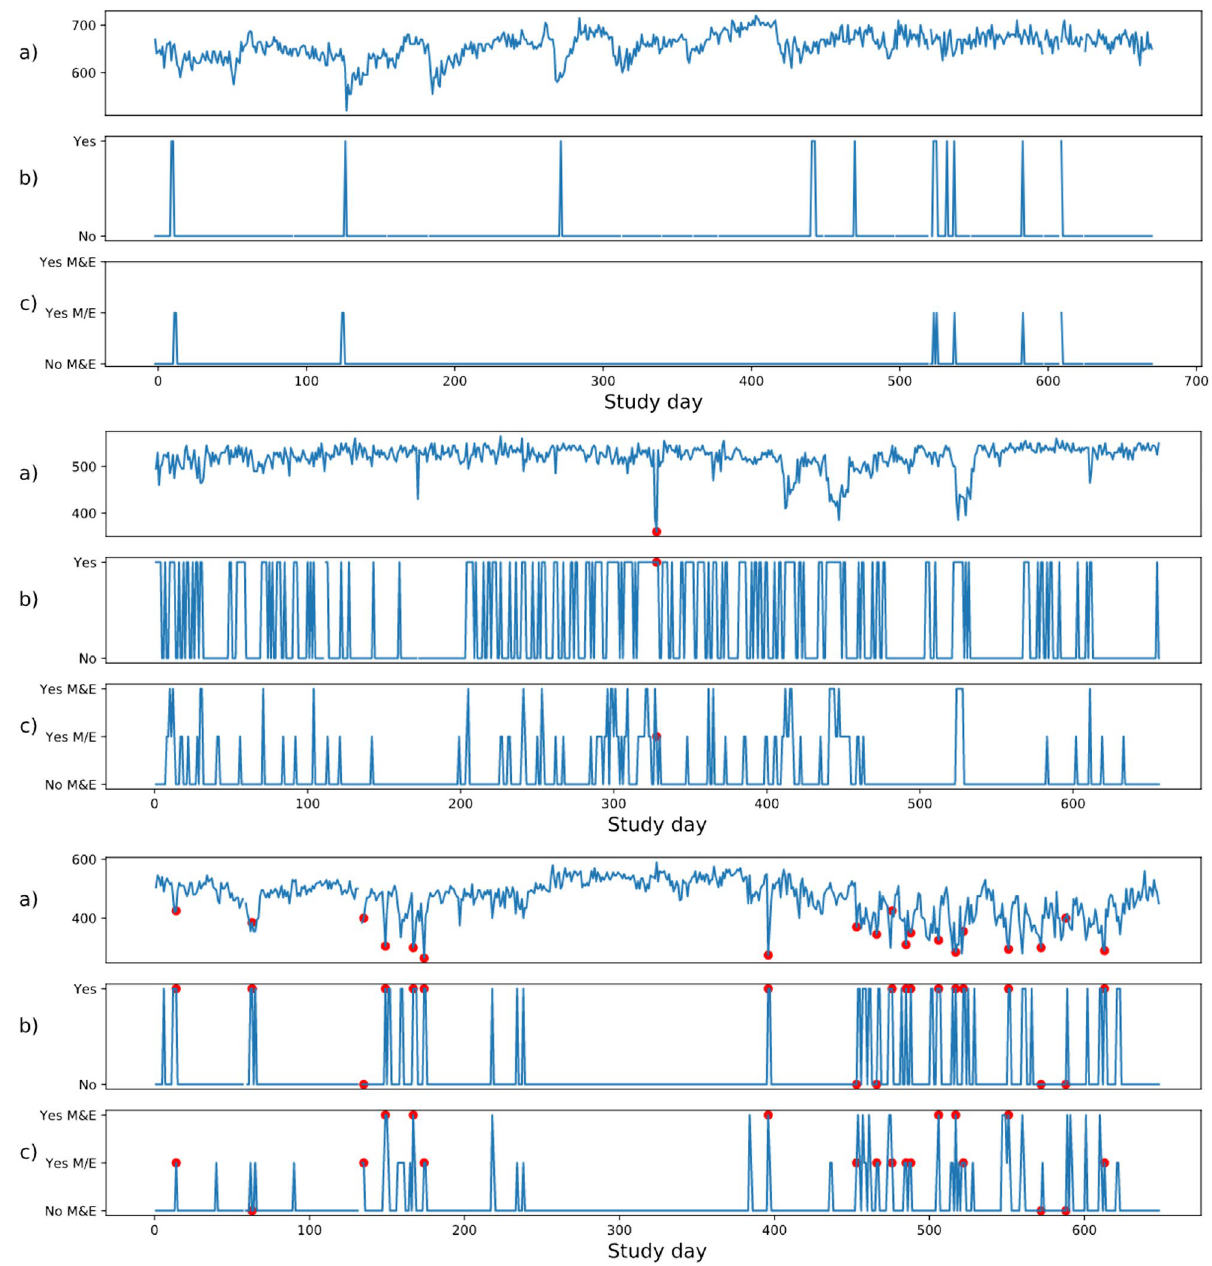
Figure 1. Time series for patients with no, one and many exacerbations. ( a ) Peak expiratory flow, ( b ) nocturnal awakening (yes/no), and ( c ) use of β 2 reliever (No M&E = No Morning & Evening, Yes M/E = Yes morning or evening, Yes M&E = Yes morning and evening) over time for three patients with no, one and many exacerbations respectively. The case of no exacerbations (top figure) is most prevalent in the data. Exacerbations are marked with red dots.